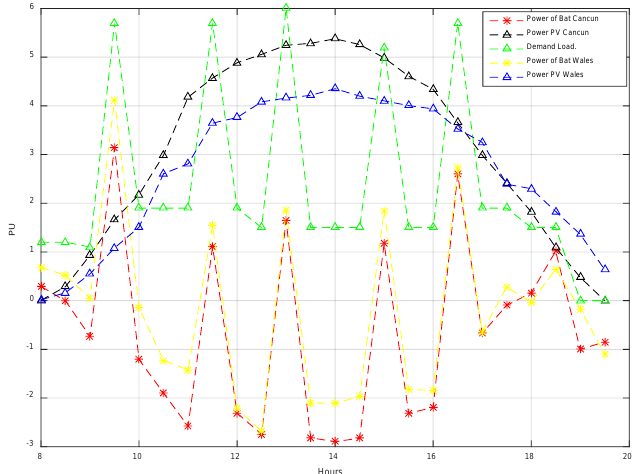
Figure 6. Result of the powers in generators for a clear summer day (Cancun and Baglan).